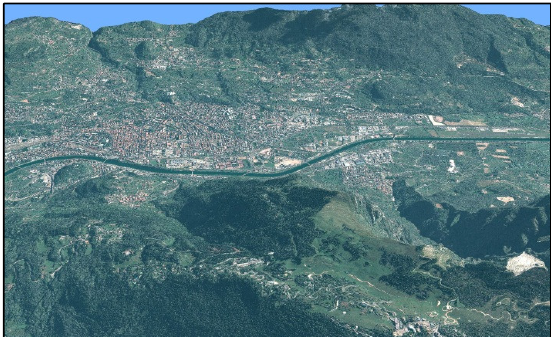
Figure 6. 3D visualization in ERDAS VirtualGIS of the textured model of Trento produced using GE1 stereo images.